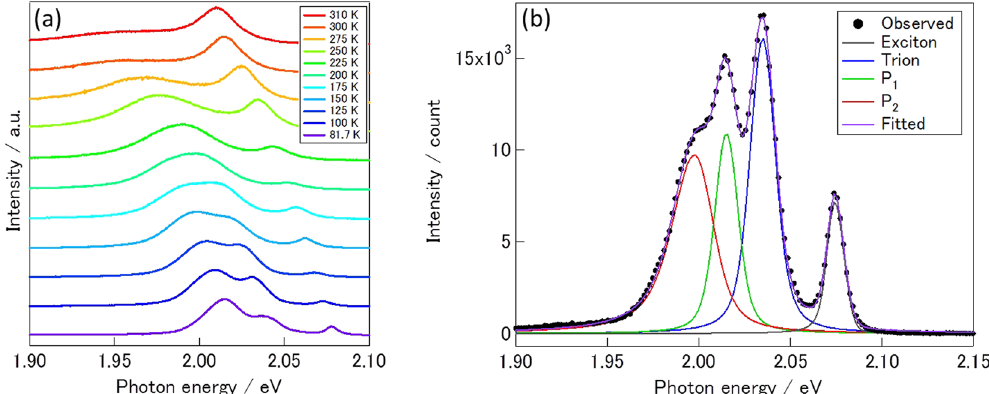
Figure 2. ( a ) PL spectra of WS 2 / h BN measured at temperatures ranging from 81.7 to 310 K. ( b ) A PL spectrum of WS 2 / h BN measured at 80 K. Contribution from excitons, trions, P 1 and P 2 , which are shown by black, blue green and red curves, respectively, are modeled by the pseudo-voigt function. Excitation energies of 2.54 eV and 2.38 eV were used to measure spectra in ( a ) and the spectrum in ( b ),